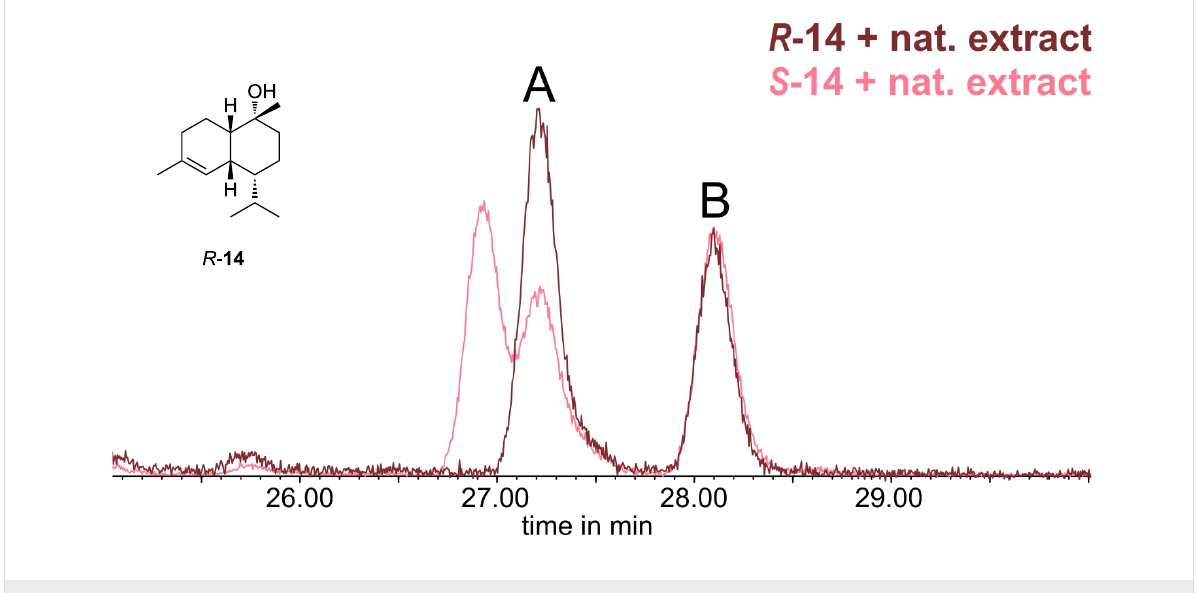
Figure 6: Coinjection of R- 14 and S- 14 with a gular gland extract of Hyperolius cinnamomeoventris performed with a Hydrodex β -6TBDM column. Compound B serves as relative standard to target compound A .